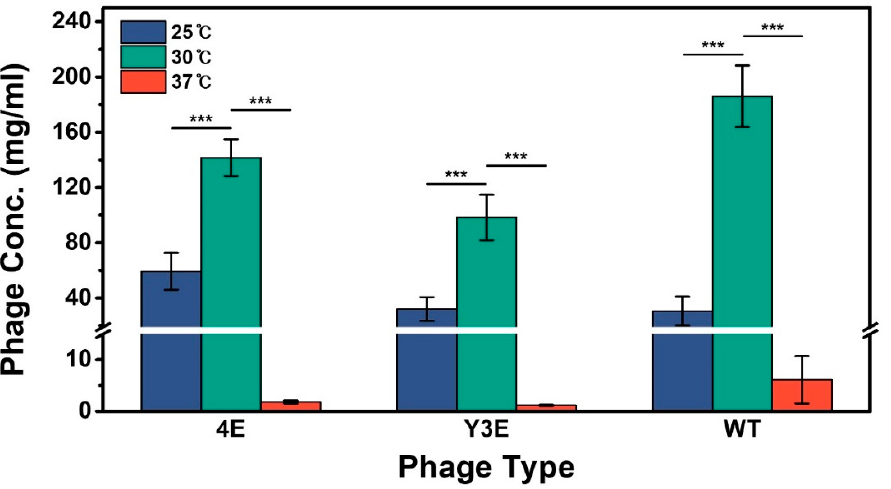
Figure 5. Concentration of genetically engineered M13 phage (4E and Y3E) and WT phage fer- mented at each culture temperature. Genetically engineered M13 phages were produced from 16 h of fermentation with XL1-Blue E. coli and were measured using UV-vis spectroscopy after concen- tration/purification via PEG precipitation to identify phage concentrations. Similar to WT, both Y3E and 4E phages produced the highest concentrations at 30 °C culture temperature, followed by 25 °C and 37 °C. n = 3 for each data point. *** p < 0.001.